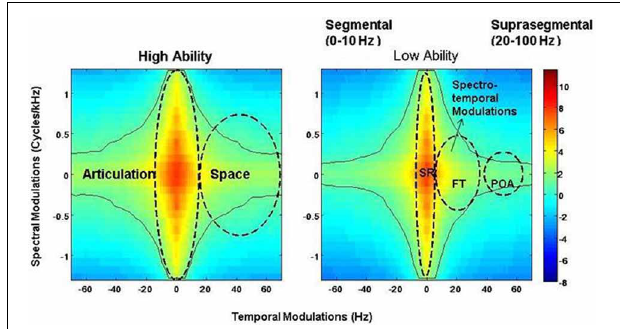
FIGURE 2 | Speech modulation spectra for the low and high ability groups, demonstrating the “articulation space” and the presence of different articulatory features. Articulatory features are classified based on different time scales and classified thus: SR = syllabic rhythm, 0–20Hz; red bars- FT = formant transition, 25–40Hz; green bars – POA = place of articulation, 50–100Hz. Color-coded bar reflects intensity of energy/power distribution. Notice differences between energy intensity at the POA time scale between the two